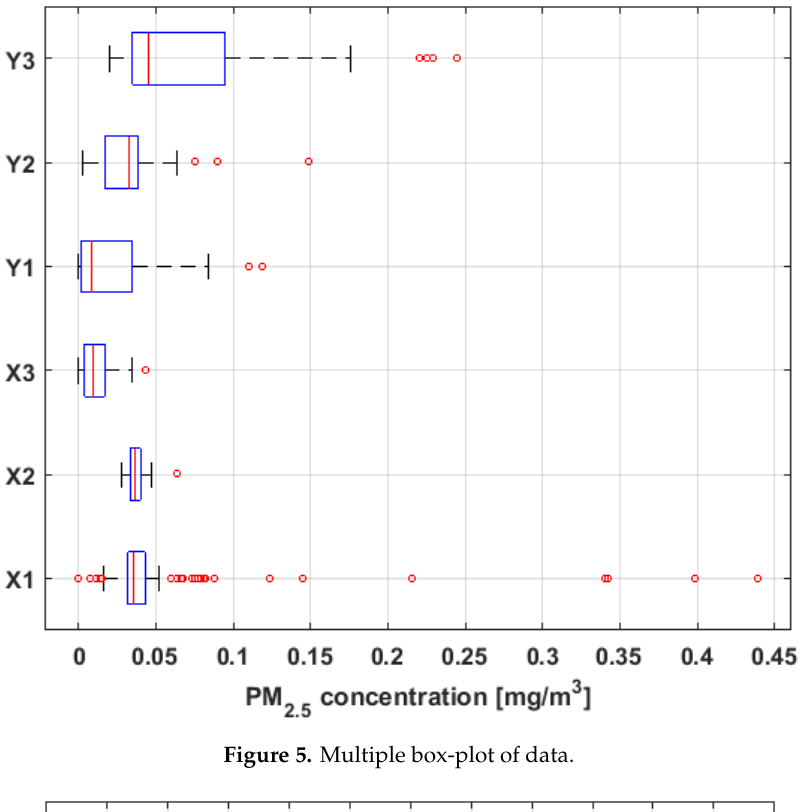
Figure 5. Multiple box-plot of data.